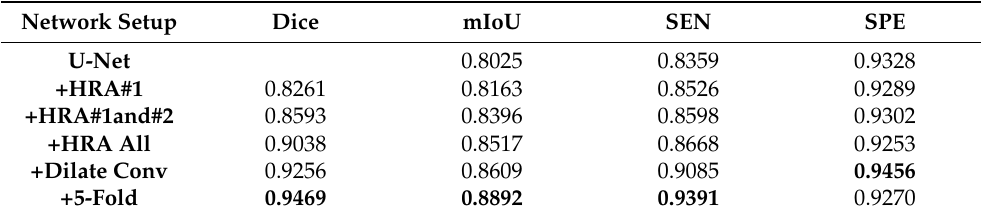
Table 6. Evaluation of different component settings on the ISIC 2018 Task1 dataset. Network